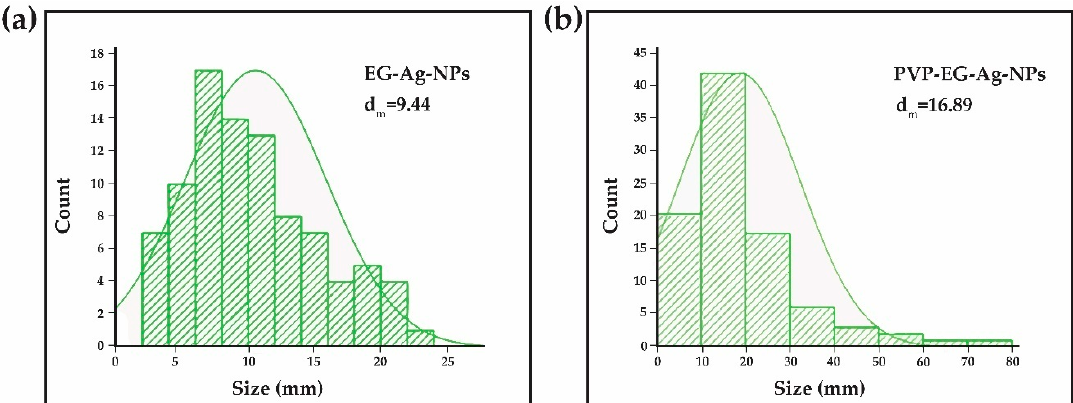
Figure 2. Histogram indicating the particle size distribution: ( a )Ag-NPs functionalized with ethylene glycol (EG-Ag NPs); ( b )Ag-NPs functionalized with polyvinylpyrolidone and ethylene glycol.